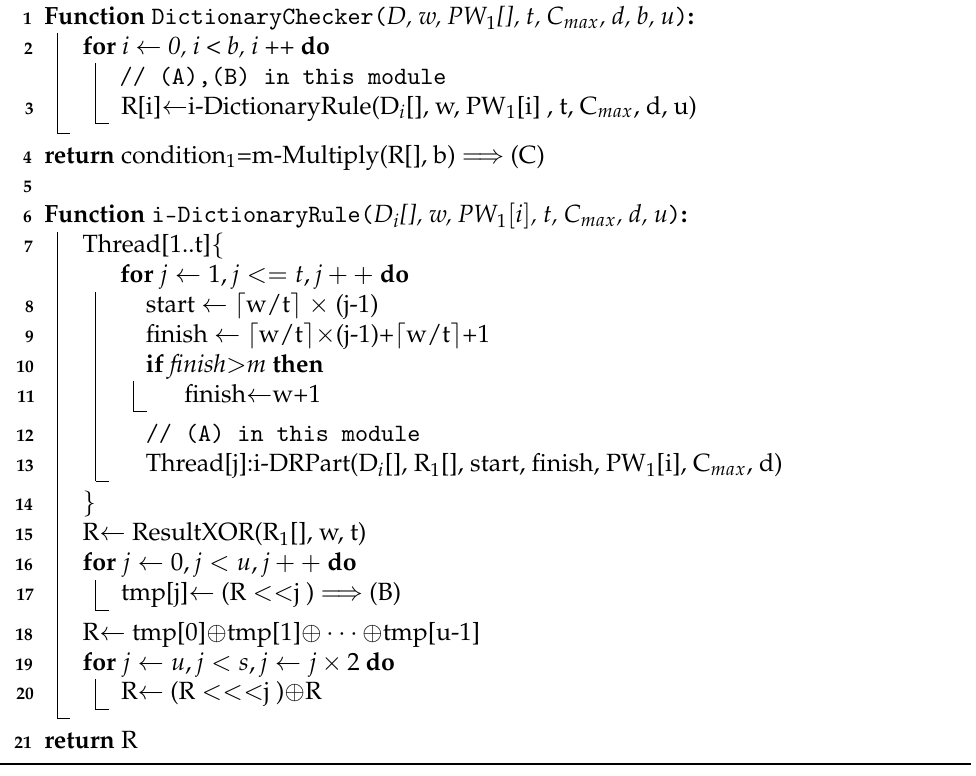
Algorithm 2: Pseudo-code of Dictionary Checker